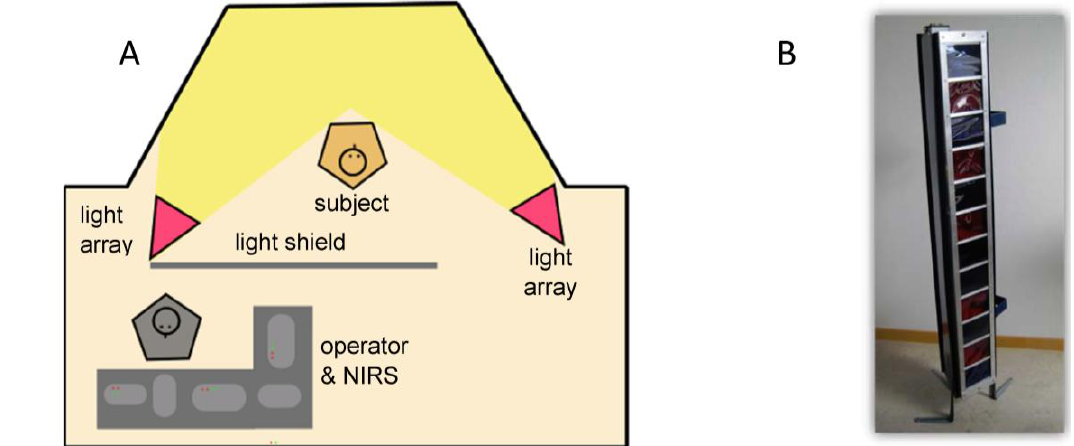
FIGURE 1. (A) Setup of the experiments. The subject was sitting in front of a white wall. During the nonexposure phases, the room was dark. During exposure, red or blue light was projected onto the wall by use of the light arrays, thereby resulting in an appearance of the wall in the respective color. The subject sat comfortably, with one near-infrared sensor attached to the left forehead and one sensor attached to the left calf muscle. The operator controlled the lighting and NIRS instrumentation. Light from the instrumentation was dimmed and additionally shielded. (B) Light exposure array. The figure shows one of two light bulb arrays, where blue and red light filters were alternatingly mounted to generate red and blue light for the exposure